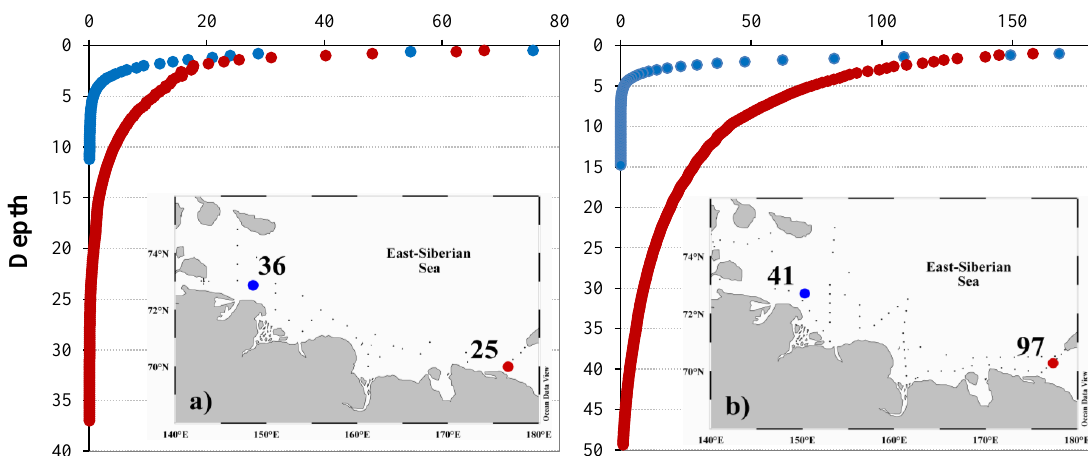
Fig. 12. Profiles of PAR in the ESS in September 2003 (a) and September 2004 (b) .